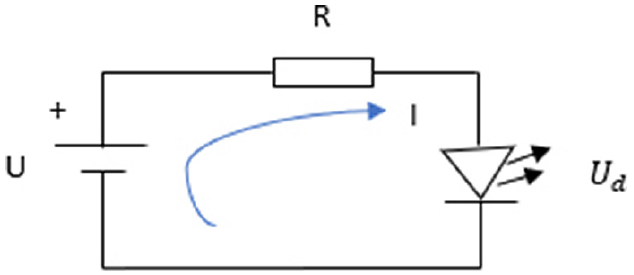
Fig. 14. Connecting the LED in series with the resistor for its